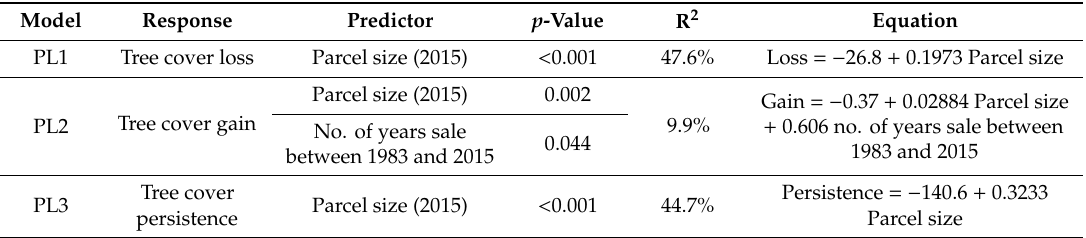
Table 5. Best fit multiple regression model to predict the tree cover loss, gain and persistence in parcel